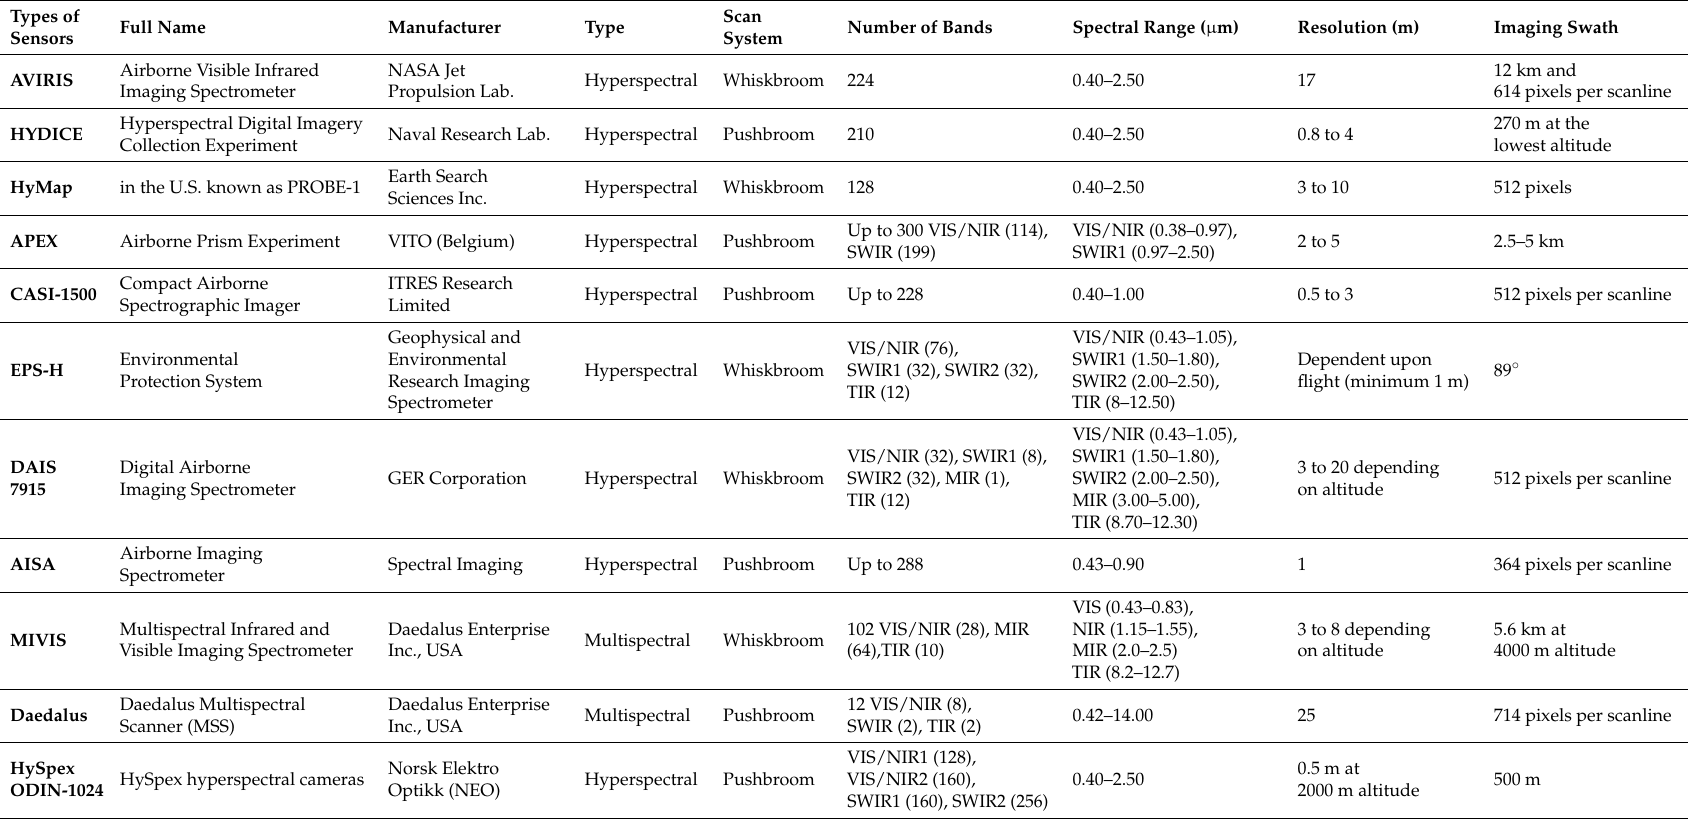
Table 2. Specification of the more commonly used airborne sensors in water quality